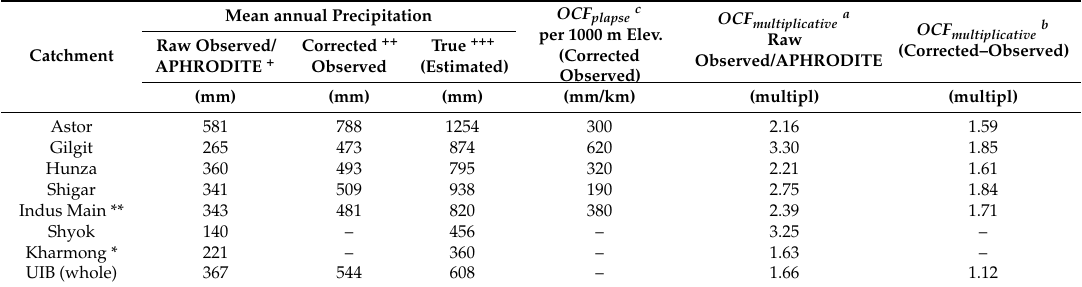
Table 7. Mean annual precipitation and different orographic correction factors (OCF) for the various catchments of the